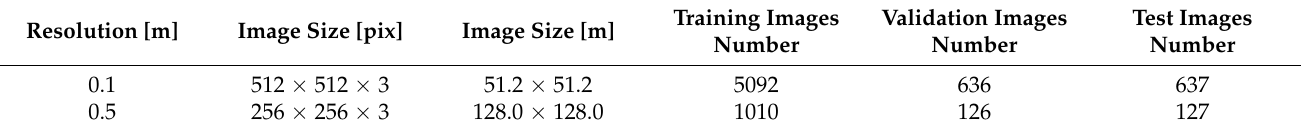
Table 1. Summary of created